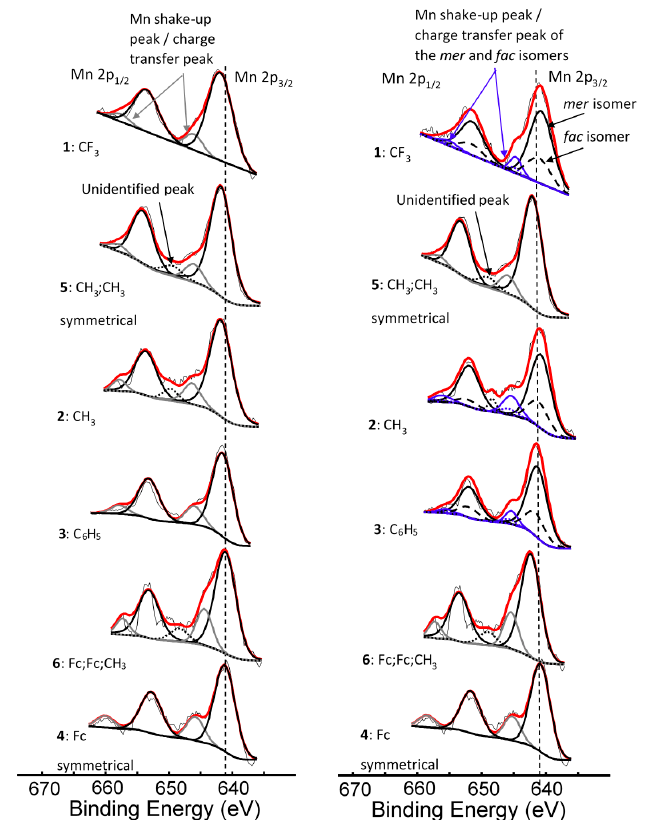
Figure 2. Left : Comparative XPS spectra showing a single peak fitted for all the main Mn 2p peaks as well as the shake-up peaks of the Mn 2p area of complexes 1 – 4 , [Mn(FcCOCHCOR) 3 ], 5 , [Mn(CH 3 COCHCOCH 3 ) 3 ] and 6 , [Mn(FcCOCHCOFc) 2 (FcCOCHCOCH 3 )]. Right : Comparative XPS spectra showing one peak fitted for the main Mn 2p peaks of the complexes having symmetrical β - diketonato ligands and two simulated peaks for the complexes with unsymmetrical β -diketonato ligands, representing the mer and fac isomers (a ratio of 3:1 was forced into the simulation) as well as the shake-up peaks of the Mn 2p area of complexes 1 – 6 . In some cases, a surface peak from the interface of Mn complexes attached to the carbon tape was identified and is shown with …. lines. The vertical dotted lines give an indication of how the binding energy shifts.